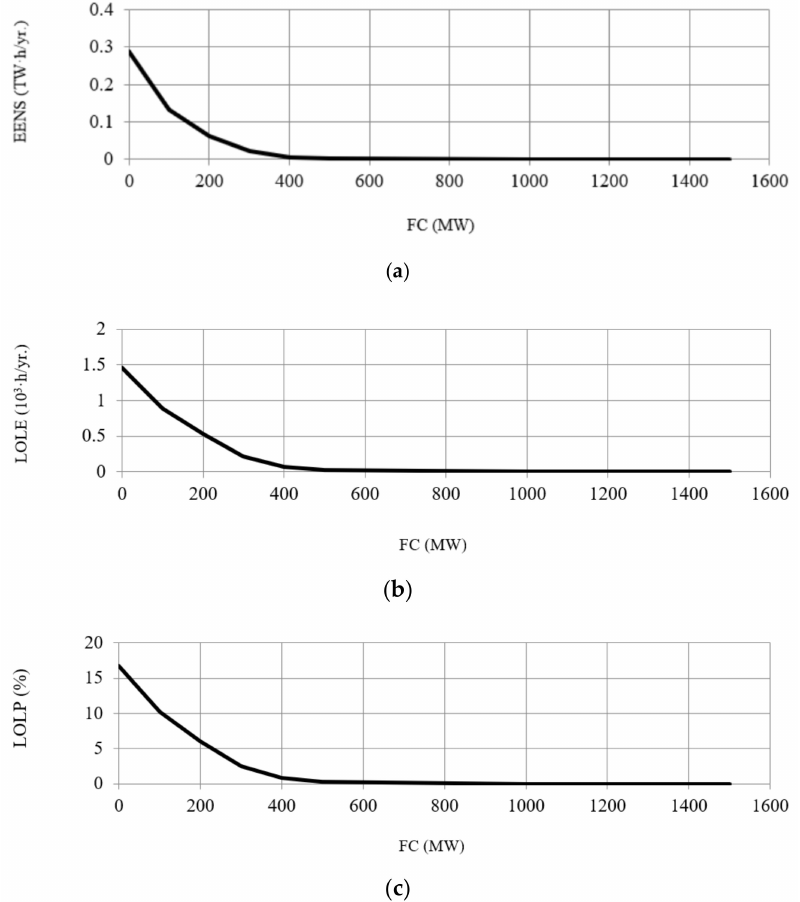
Figure 6. The probabilistic reliability indexes ( a ) expected energy not served (EENS); ( b ) loss of load expectation (LOLE); and ( c ) loss of load probability (LOLP) for the Croatian power system assessed for the model of isolated power systems and worst-case